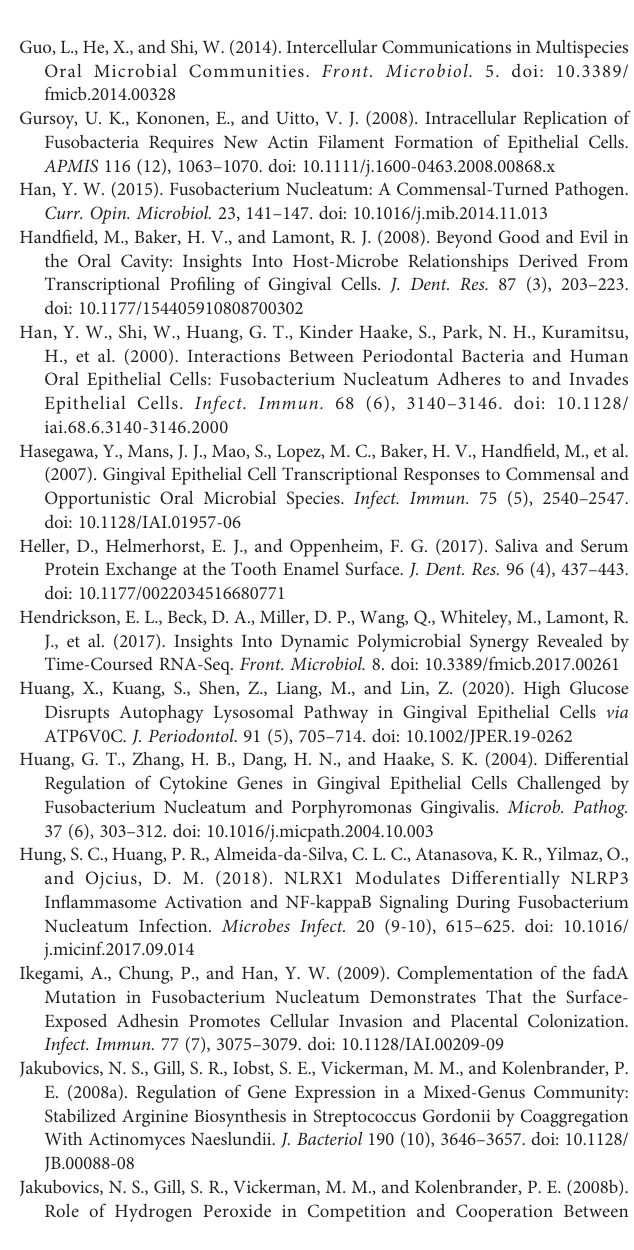
Supplementary Figure 1 | (A) Extracellular bacteria after antibiotic treatment with 200 m g/mL metronidazole and 300 m g/mL gentamicin for 60, 90 and 120